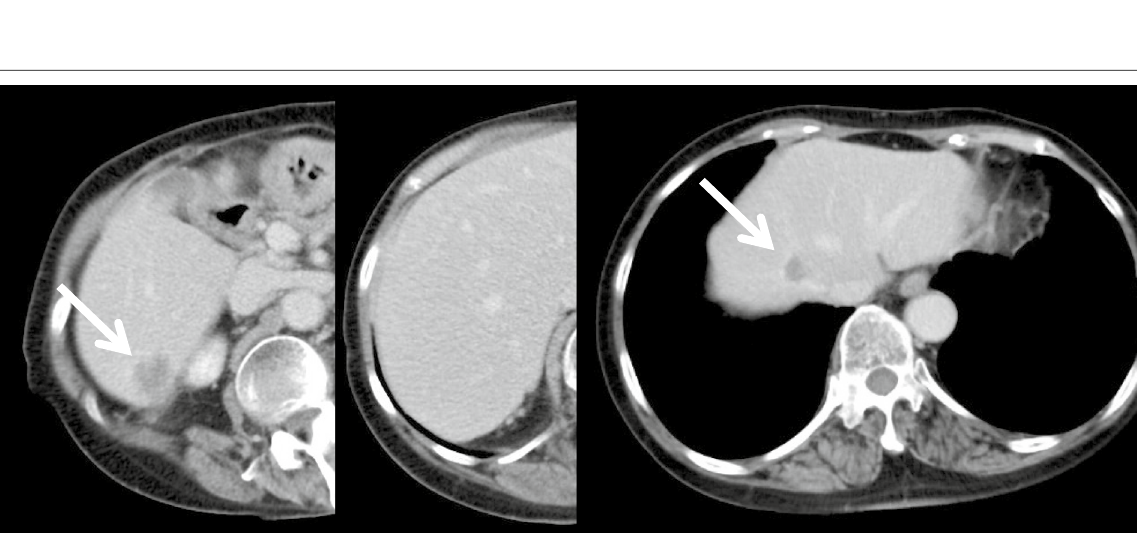
Fig. 5 Abdominal CT scan showing reduction of liver metastases by chemotherapy (white arrow). CT computed tomography